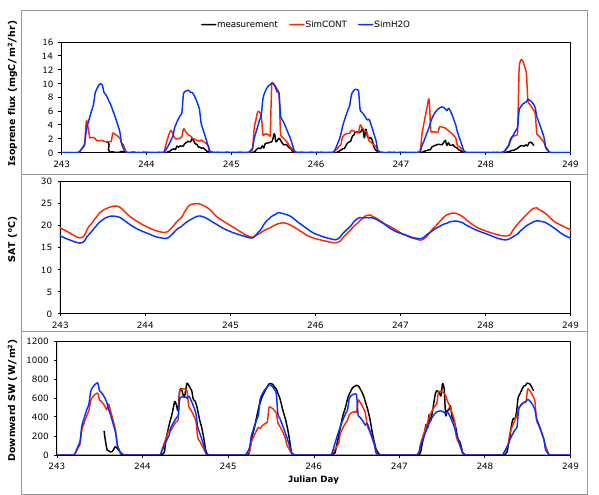
Figure 8e. Results for Harvard Forest during August 31 – September 6 2007. Fig. 8e. (a–e) Time evolution of isoprene emission flux, surface air temperature (SAT) and downward shortwave (SW) radiation at the temperate measurement sites. Measurements are shown in black (where data is available). Model climatological results are averages of 10 simulation years in SIMCONT (red) and SimH2O (blue). (e) Figure 9(a). Comparison between measured and modeled isoprene emission average